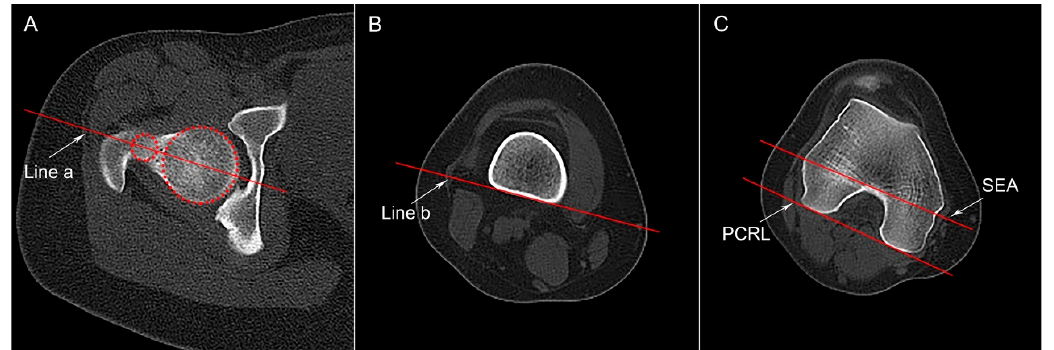
Figure 1. Segmental femoral torsion parameters. ( A ) An axial CT slice showing the intact femoral head and neck is selected. The two circles were drawn to the margin of femoral head and neck to identify the center of the head and neck; Line a passes through the center of both the femoral head and the neck. ( B ) Distal femoral shaft line (Line b) is tangent to the posterior bony margin of the femoral shaft on the slice above the gastrocnemius insertion. ( C ) An axial slice showing an intact “Roman Arch” and the femoral condyles. The posterior condylar reference line (PCRL) was drawn tangent to the posterior femoral condyles; the surgical transepicondylar axis (SEA) passes through the sulcus of the medial epicondyle and the prominence of the lateral epicondyle.